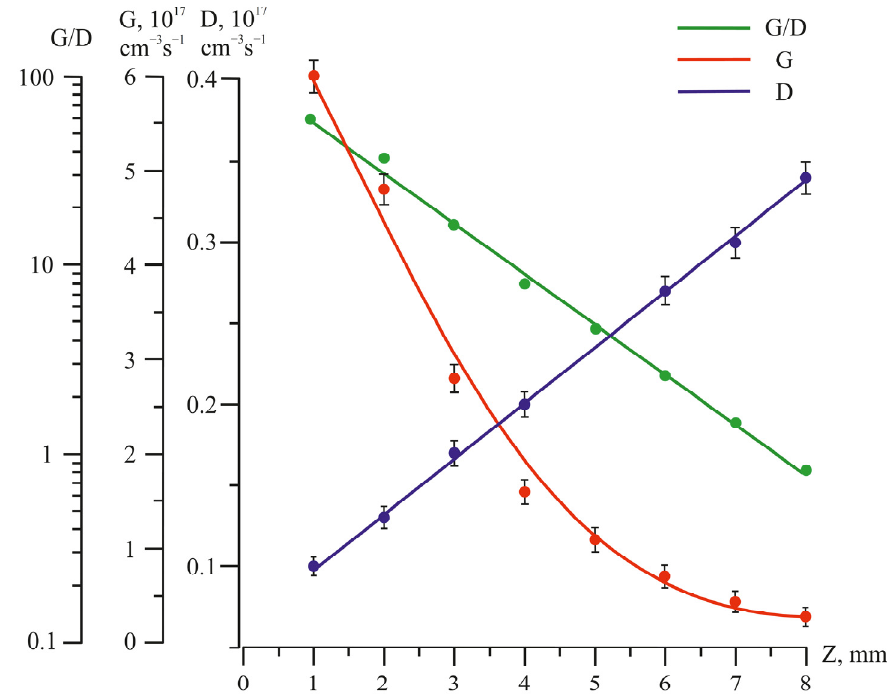
Figure 8. Axial dependences of quantities D (1), G (2), and G / D (3). Here, G is the function of atomic excitation and ion generation; quantity D determines the departure of ions from the plasma discharge channel in the radial direction.